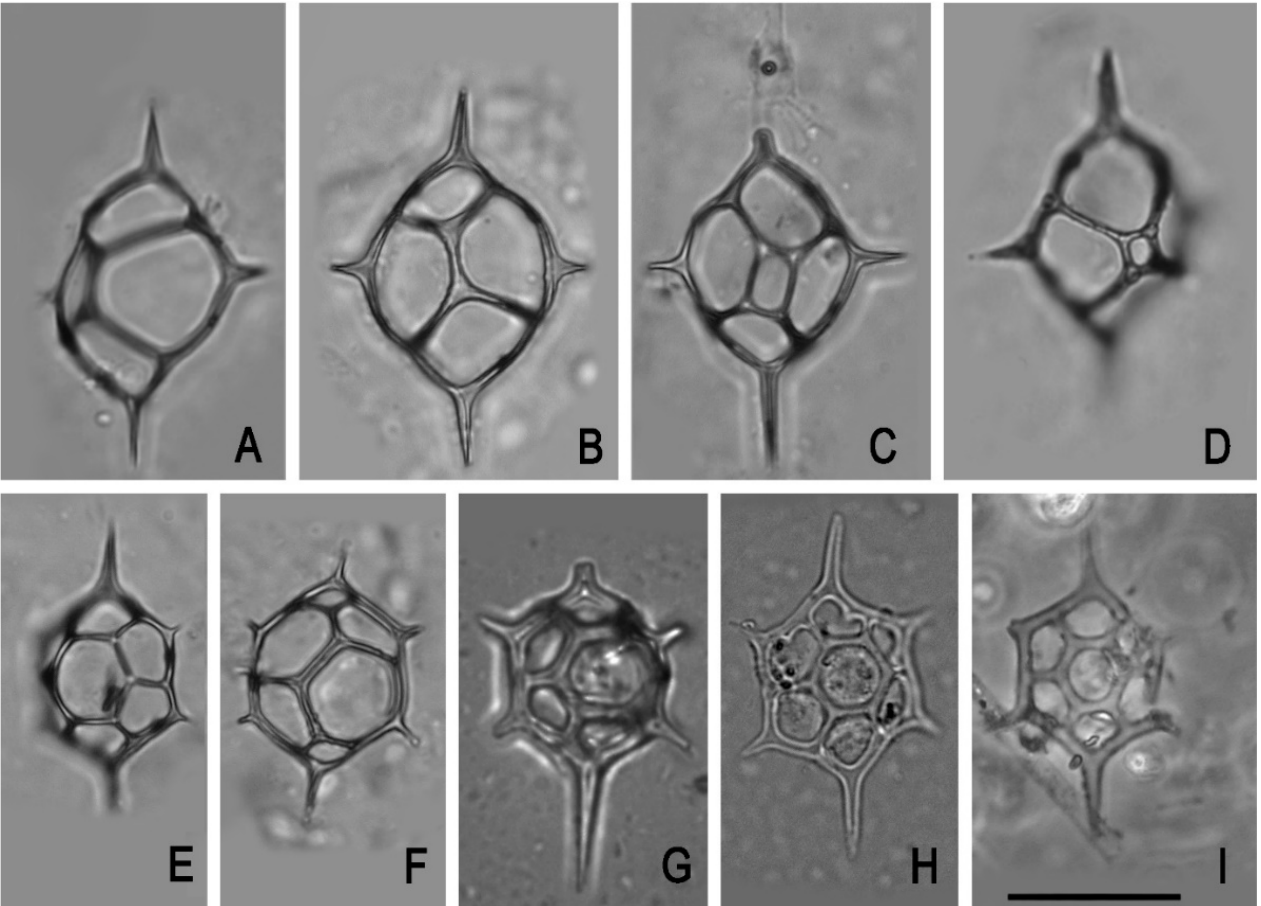
Figure 2. Silicoflagellates and diatoms found in floral honey. ( A , B ). Dictyocha fibula . ( C , D ). Distephanopsis crux . ( E ). Stephanocha speculum speculum . ( F ) . Stephanocha speculum speculum f. notabilis . ( G – I ). Stephanocha speculum. ( A – F ) from Tunisia, ( G ) Poland, ( H ) Romania, ( I ) Greece. Scale bar: 20 µm. Table 1. Silicoflagellates, diatoms, and cyanobacteria found in honey samples.